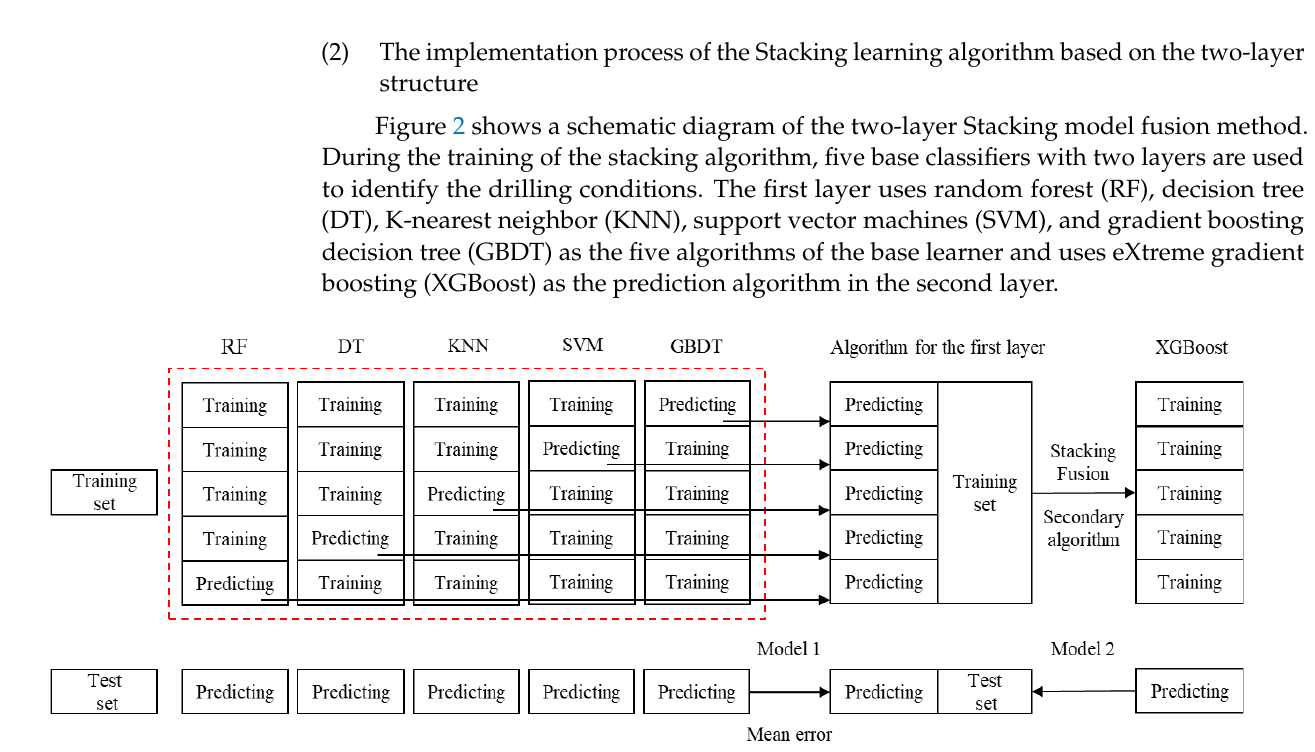
Figure 2. Schematic diagram of the Stacking algorithm for the identification of drilling conditions.